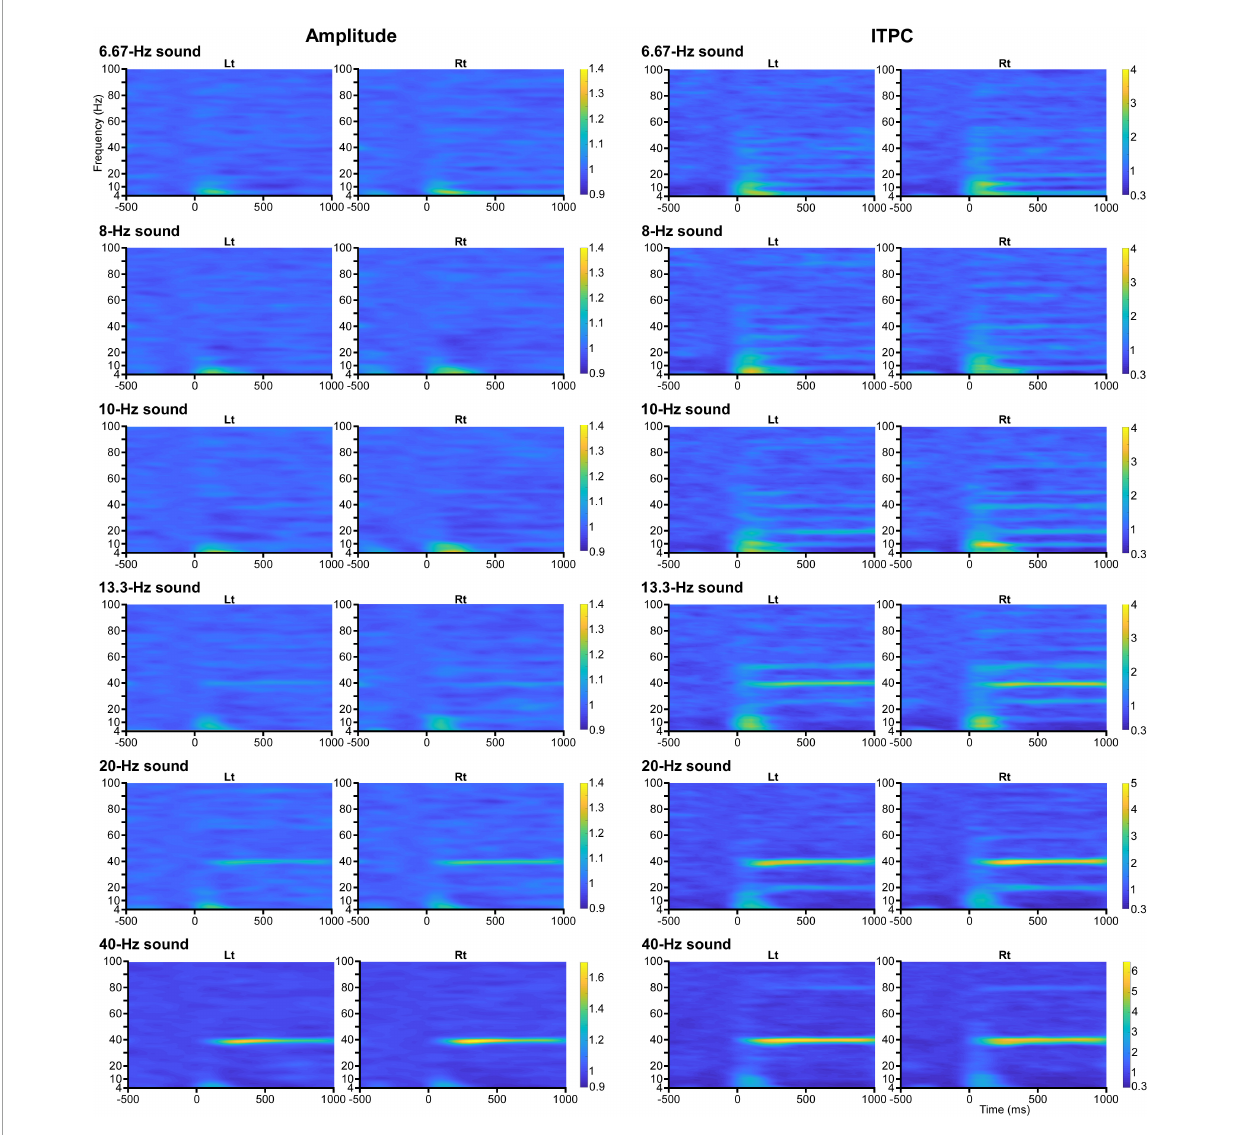
FIGURE3 Time-frequency maps. Grand-averaged time-frequency maps of amplitude (left panel) and ITPC (right panel) to the baseline for each